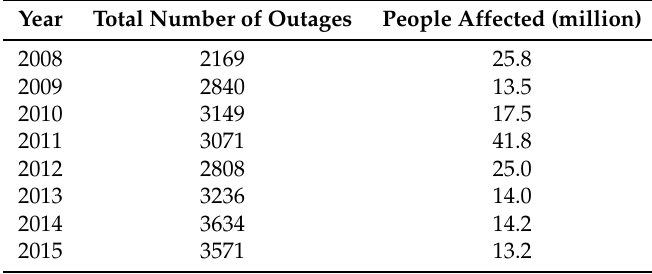
Table 4. The total number of blackouts recorded in the USA from 2008 to 2015 [54,56].